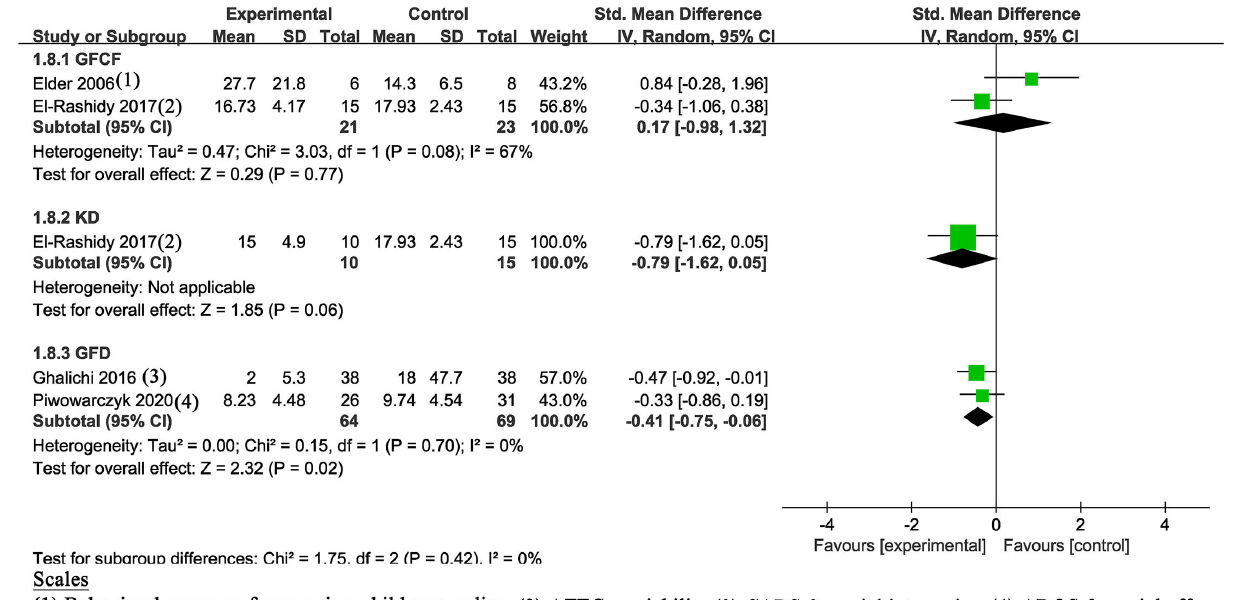
FIGURE 6 | Meta-analysis results and scales for social behaviors. ATEC, Autism Treatment Evaluation Checklist; GARS-2, Gilliam Autism Rating Scale, Second Edition; ADOS-2, Autism Diagnostic Observation Schedule, Second